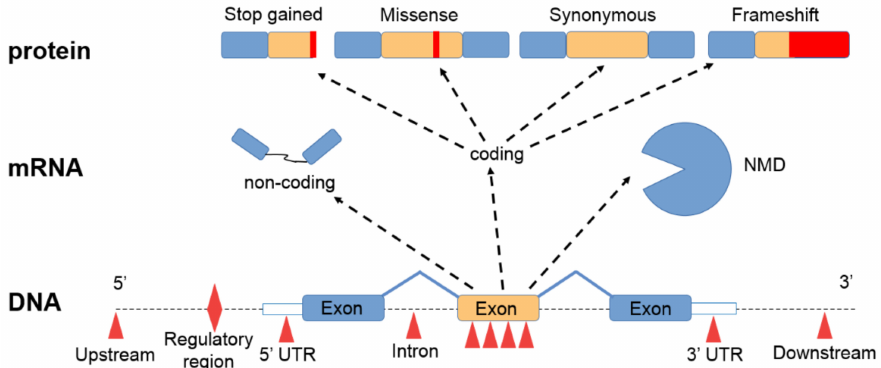
Figure 2. E ff ects of sequence alterations. Sequence variants in regulatory regions can activate or inhibit transcription. Mutations in exons result in an altered mRNA. Repair mechanisms, such as nonsense-mediated mRNA decay (NMD), can eliminate such abnormal mRNAs. As a result, missense mutations cause amino acid changes, while synonymous mutations result in the original amino acid sequence. Premature stop codons result in terminated amino acid sequences. Base insertions or deletions lead to frameshift mutations resulting in completely di ff erent proteins.